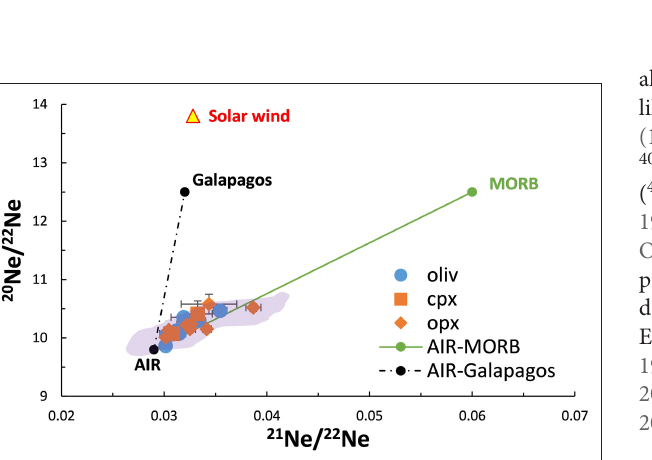
FIGURE 4 | Elemental concentrations measured in FI after single-step crushing of CO 2 vs. (A) He, (B) N * 2 ; diagram of concentrations of Ar* vs. (C) He and (D) CO 2 .